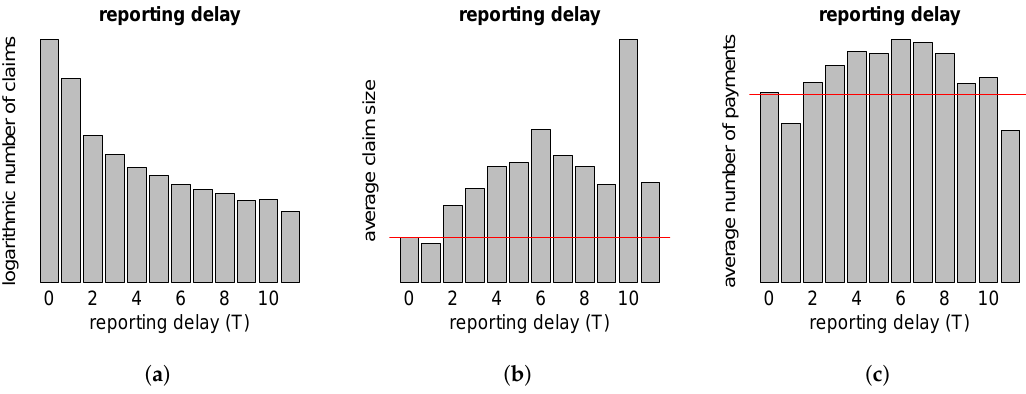
Figure A2. ( a ) Logarithmic number of claims; ( b ) average claim size and ( c ) average number of payments w.r.t. the reporting delay T ; the red lines show the